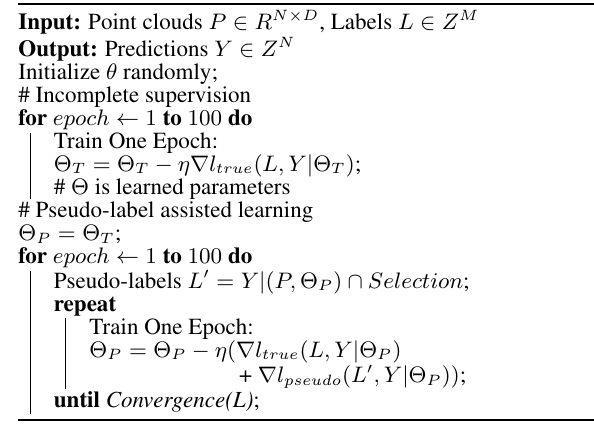
Algorithm 1: Pseudo-label assisted Point Cloud Semantic